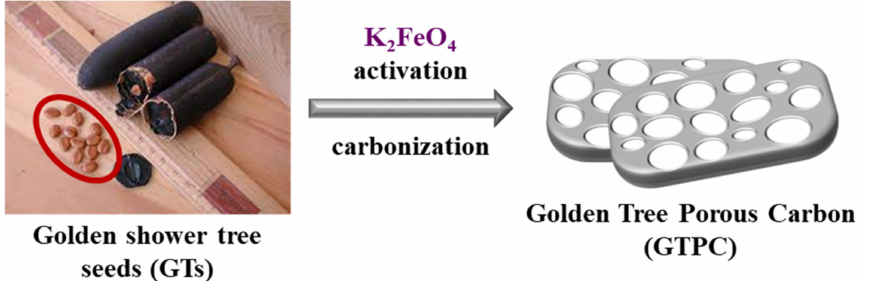
Scheme 1. Schematic illustration of synthesis of golden shower tree derived porous carbon